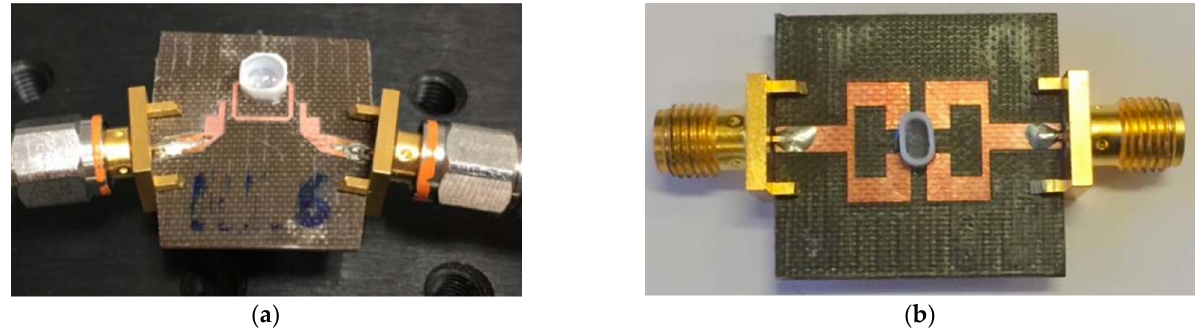
Figure 5. Examples of Q u -based sensors: ( a ) Single SRR sensor with dielectric sample holder. © (2019) IEEE. Reprinted, with permission, from [94]. ( b ) Pair of mutually coupled SRR exploiting inter-resonators coupling. © (2019) IEEE. Reprinted, with permission, from [105]. Table 3. Quality factor-based sensors. AG = aqueous glucose solutions; WG = waveguide. Ref.